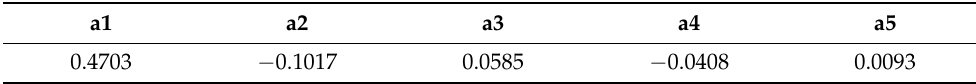
Table 6. Coefficients of the Lohrenz-Bray–Clark viscosity